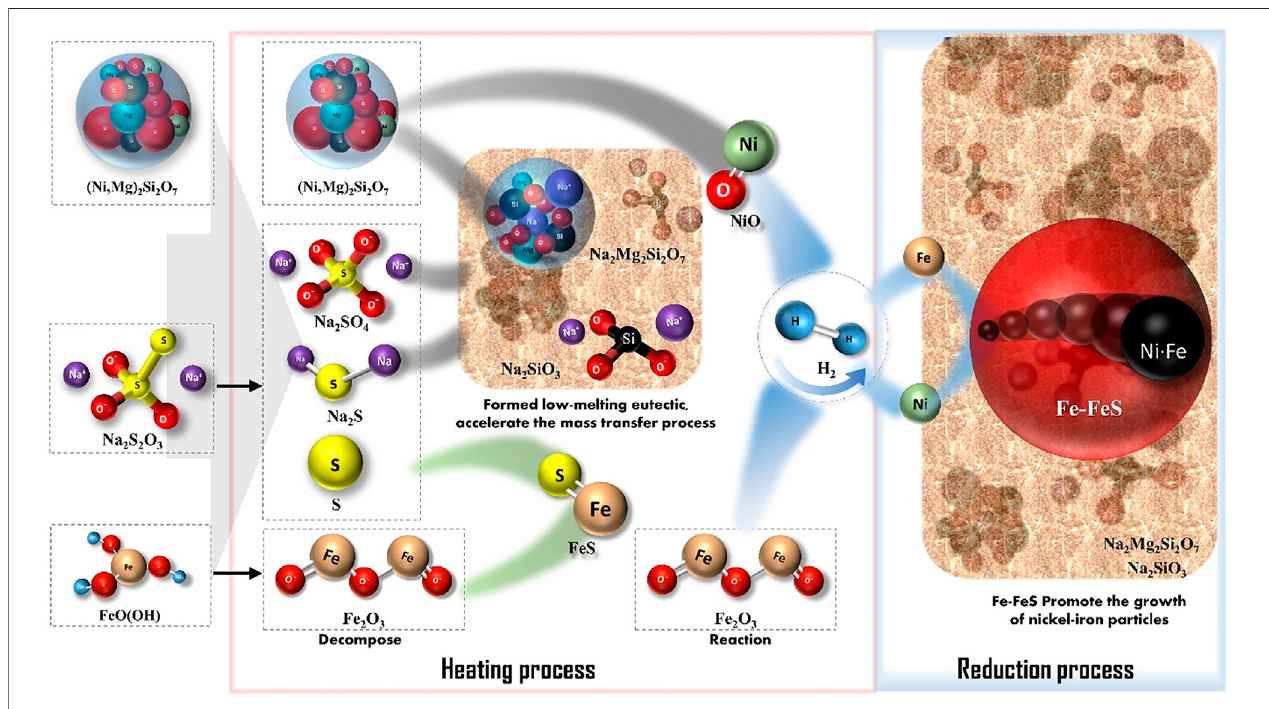
FIGURE 11 | Hydrogen-thermal reduction mechanism of laterite ore enhanced by Na 2 S 2 O 3